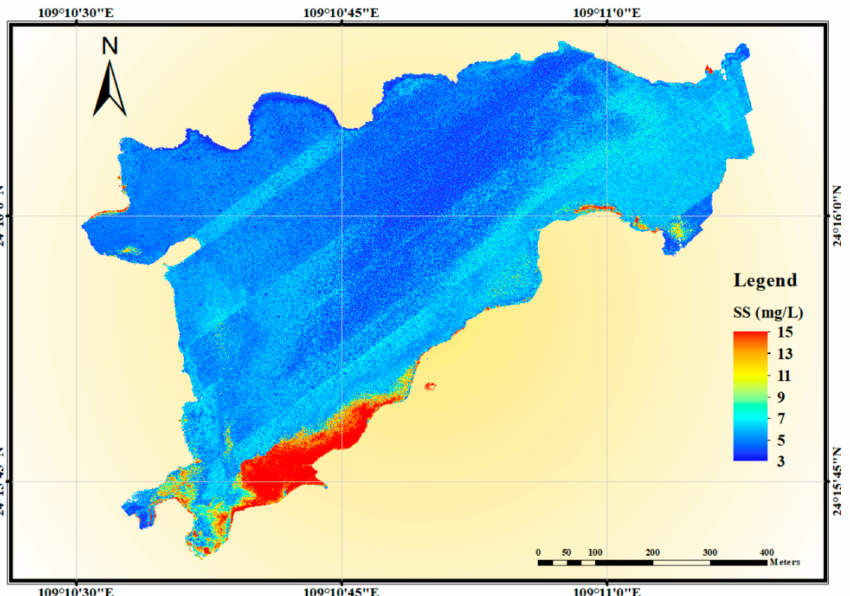
Figure 6. Distribution map of SS (mg/L) obtained using the CBR model with Beigong UAV-borne hyperspectral